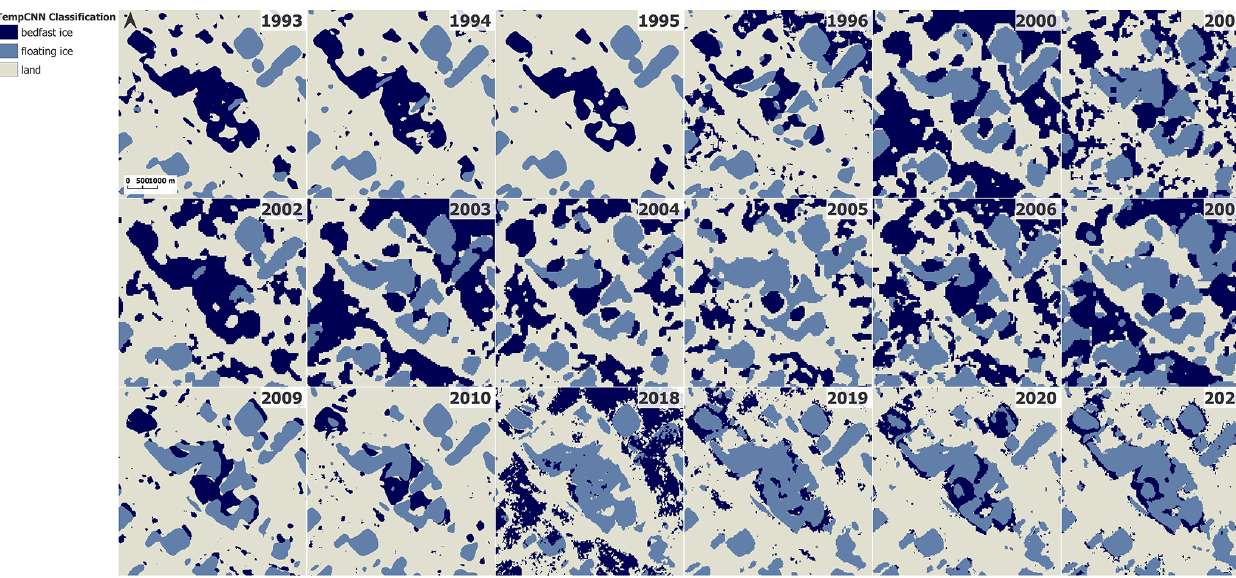
Figure 14. Netro Lake TempCNN-predicted ice regime (1992/1993–2020/2021). Dark blue represents bedfast ice; light blue – floating ice; grey – land. Between 1992/1993 and 2020/2021 the ice regime has transitioned from mostly bedfast to mostly floating.